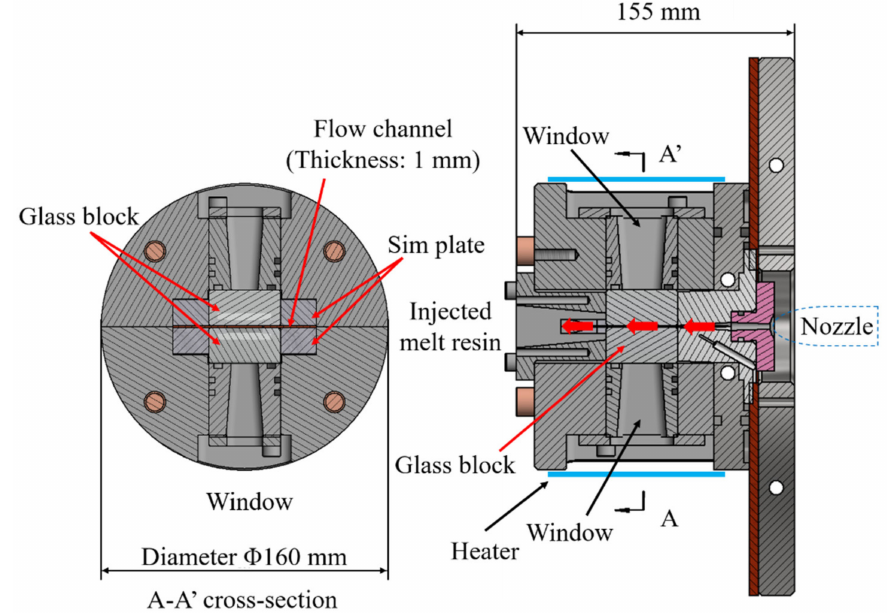
Figure 1. Fundamental structure of the newly developed evaluation mold.